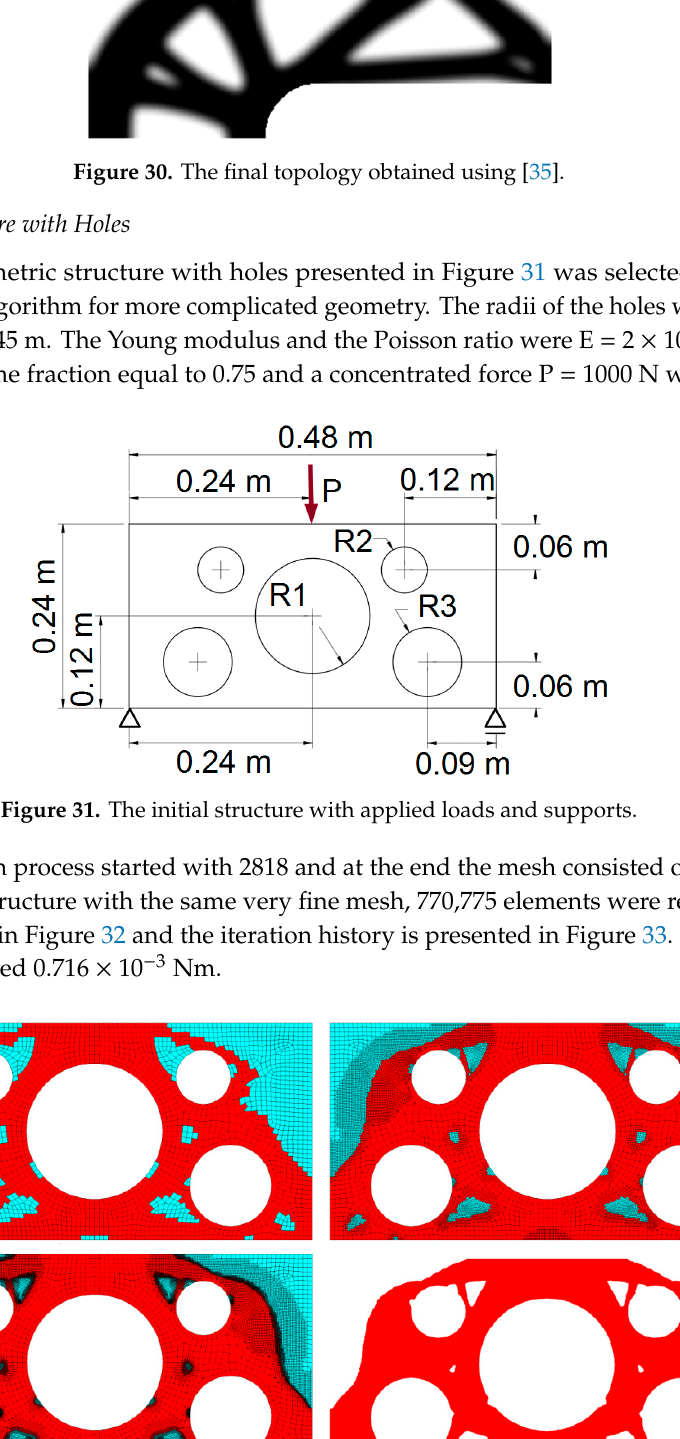
Figure 32. Selected middle topologies and the final one for the plane structure with holes. For the last iteration the grid has not been shown to improve the clarity of the picture.